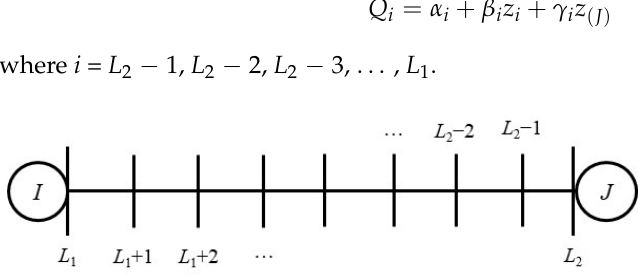
Figure 2. River discretization between the starting and ending cross-sections.